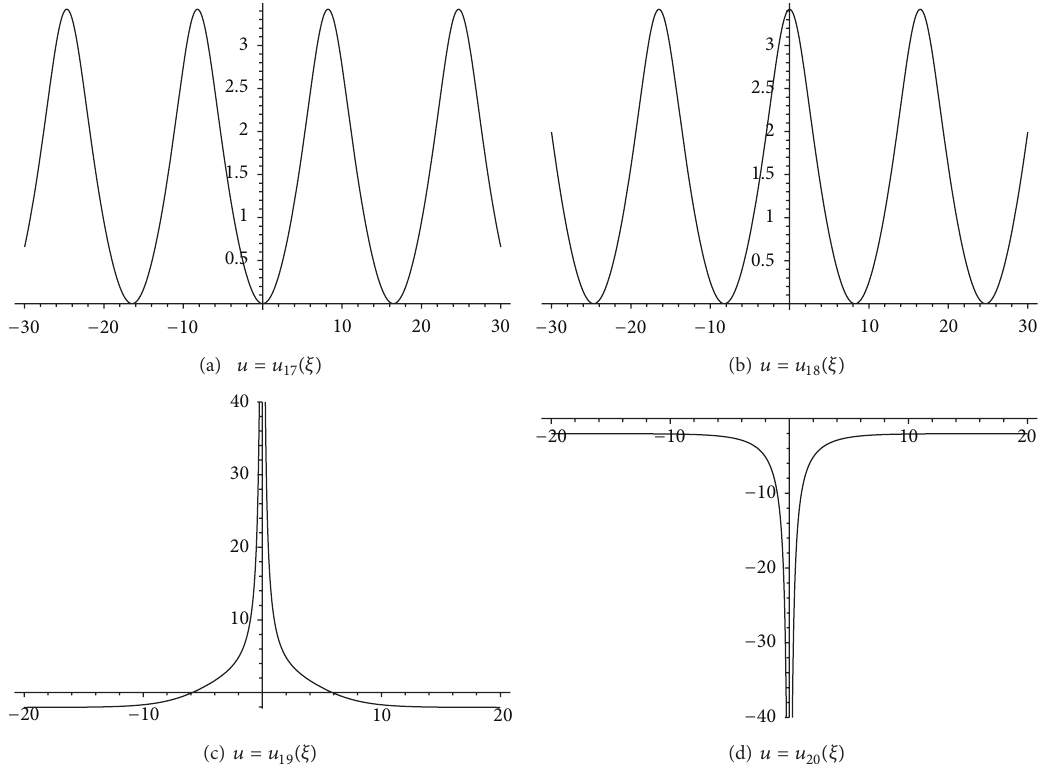
Figure 8: The graphs of 𝑢 17 (𝜉) , 𝑢 18 (𝜉) when 𝑐 = 20, 𝑔 = 0 and 𝑢 19 (𝜉) , 𝑢 20 (𝜉) when 𝑐 = −16